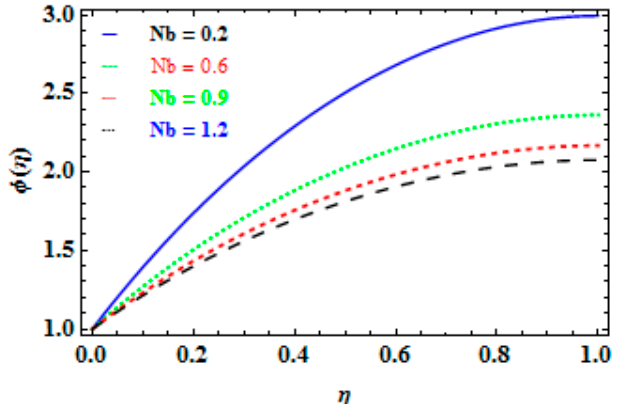
N on 𝜙 ( 𝜂 ) . Figure 15. Influence of N ( η ) . b on φ b